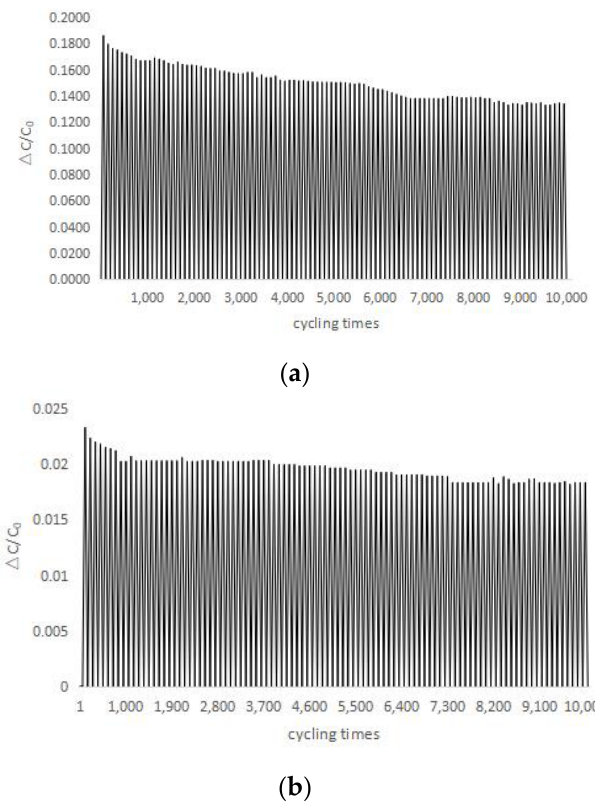
Figure 15. Fatigue of sensor under ( a ) normal pressure and ( b ) tangential